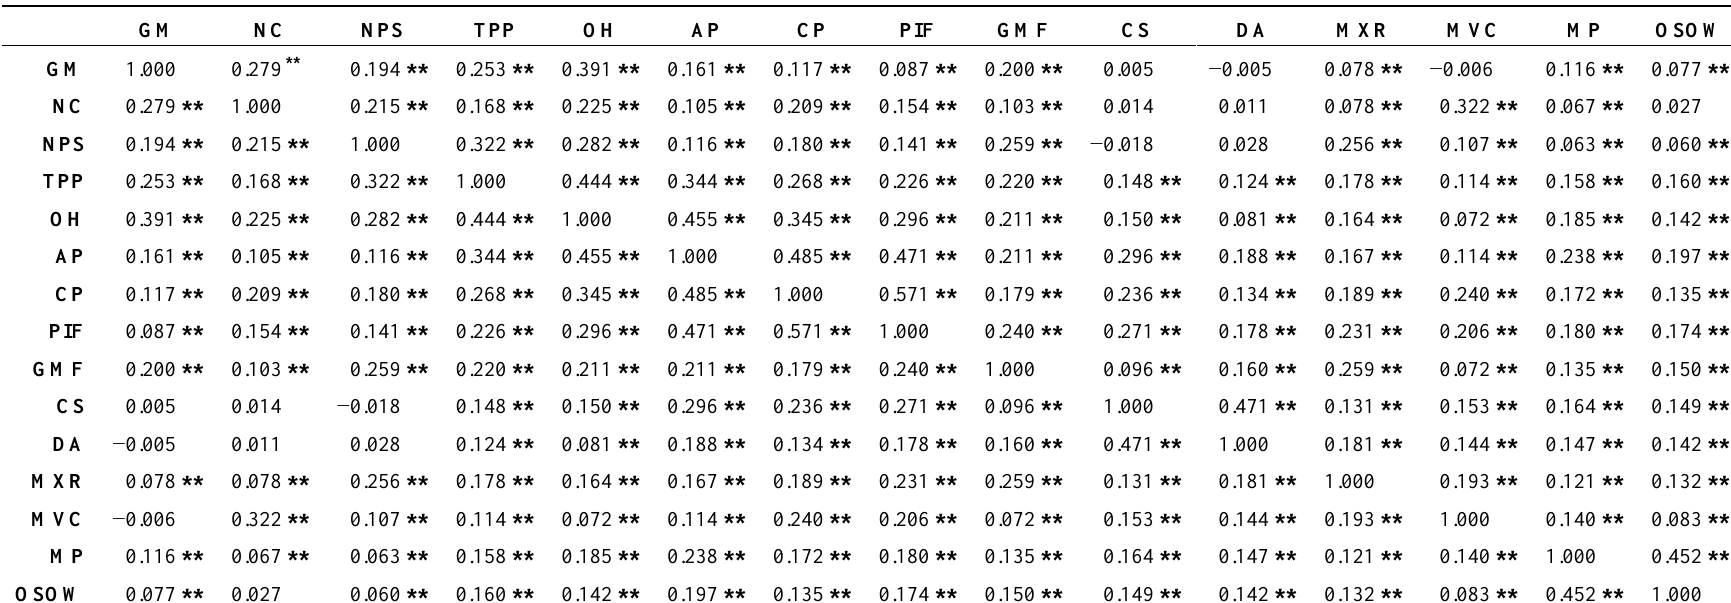
Table 5. Relationship between each health risk